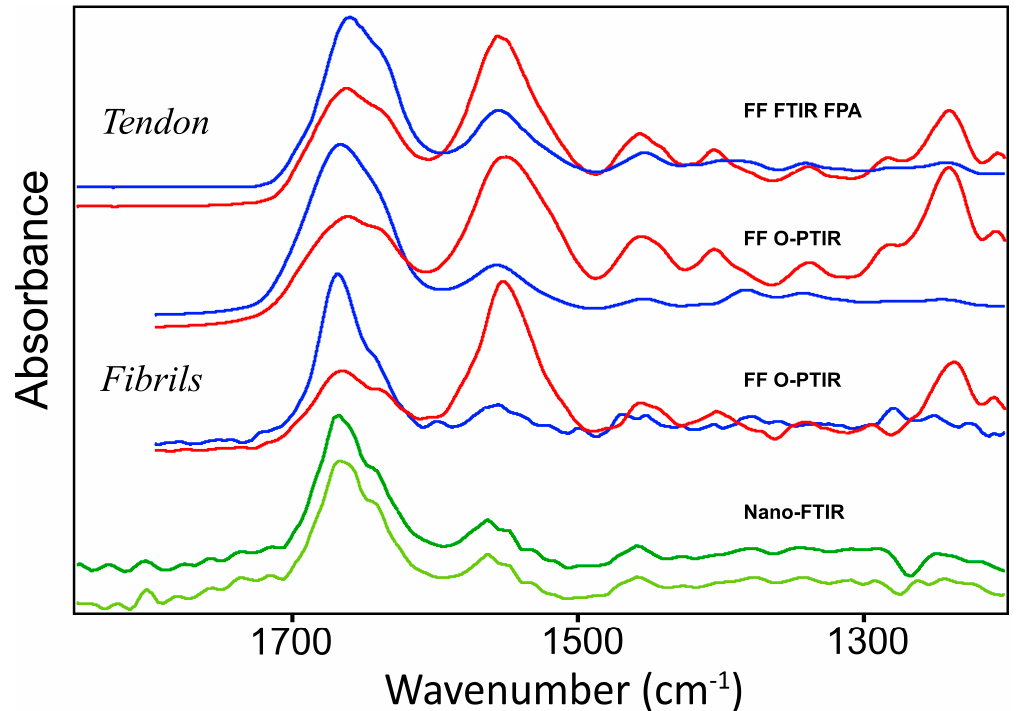
Figure 5. Averaged spectra from each experimental procedure, offset for clarity. As in other figures, all spectra with polarization parallel to fiber or fibril direction are shown in red; perpendicular are blue. Intact tendon spectra from FF-FTIR FPA and O-PTIR are sums of spectra appearing in Figures 1–3. The nano-FTIR spectra at the bottom represent sums of three separate experiments, two with lasers (dark green) and the sum of 19 spectra from ALS, bottom-most spectrum (light green).